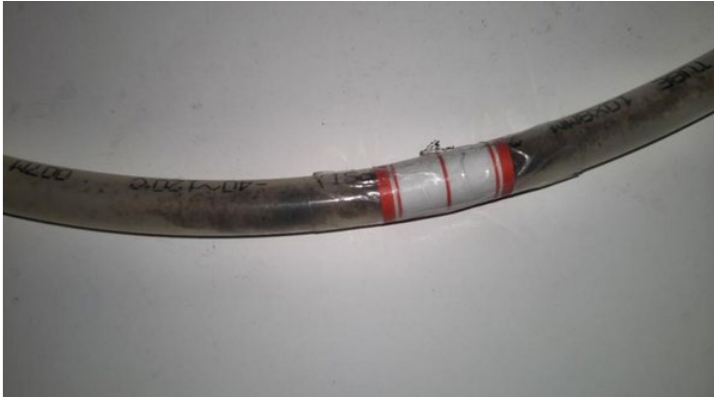
Figure 11. Photo of sediment deposition.